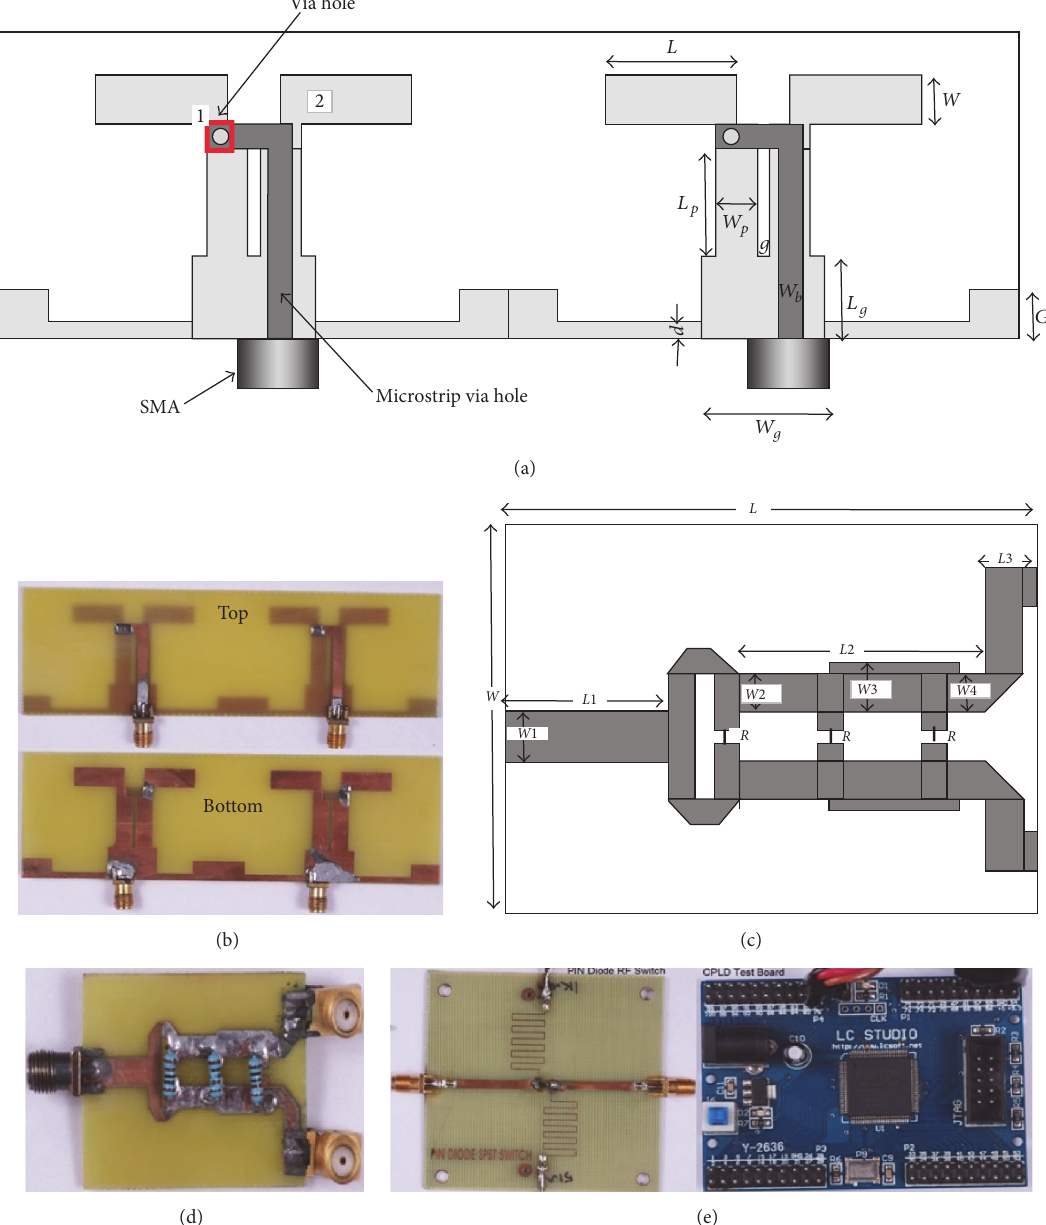
Figure 2: Elements of the TMAA: (a) configuration of the antenna array; (b) prototype of the antenna array; (c) configuration of the power divider; (d) prototype of the power divider; (e) prototype of the RF switch and CPLD test